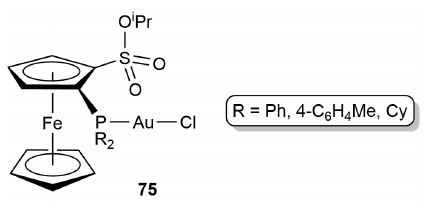
Figure 7. Structure of the water-soluble gold(I) complexes 75 .